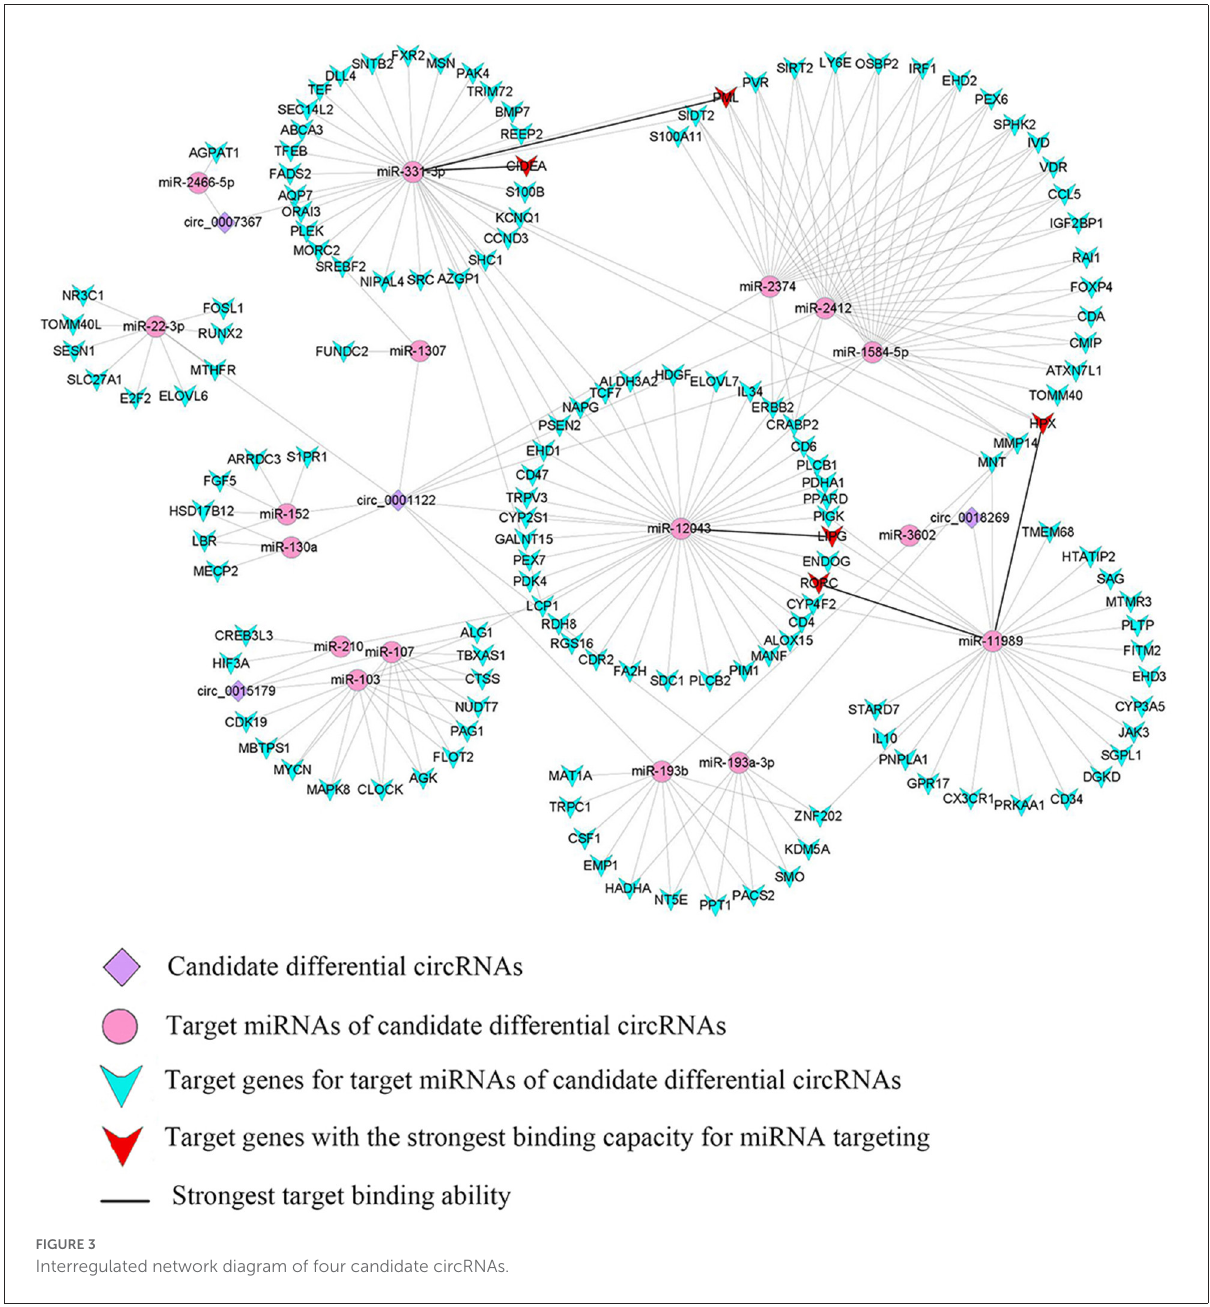
binding sites was between nucleotides 87–106, which not only matched perfectly at nucleotides 2–8 but also at bases 13 and 14 (Figure 4A). The circ_0001122:miR-12043:LIPG interplay regulation network is one of the networks to be verified in our subsequent experiments. In this network, the circ_0001122:miR- 12043 binding site was located between nucleotides 269–290 of circRNA ( Figure 4B), with nucleotides 2–8 at the seed position matching exactly, and a total of 12 seed region sequences complementarily paired with the bases of the target